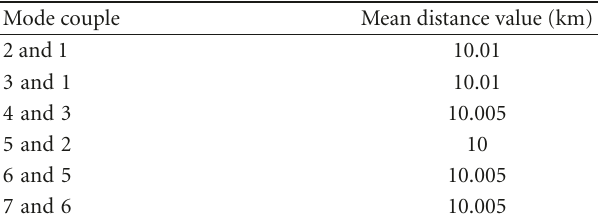
Table 4: Mean values of source distance estimation for multi- dimensional approach. The bin width is 5 m.